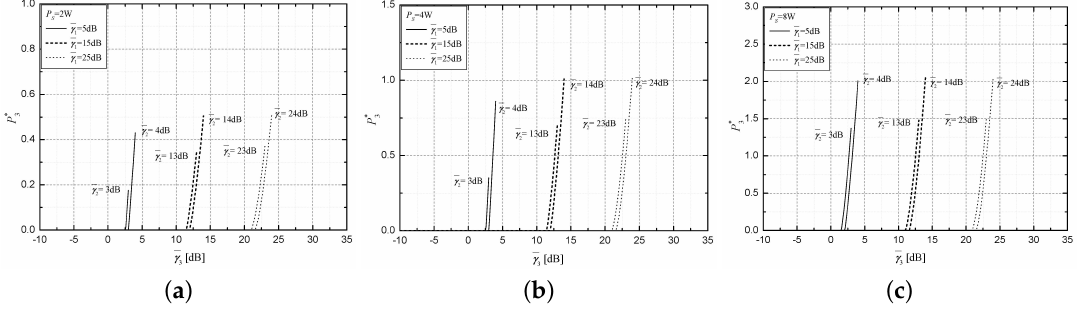
Figure 3. P ∗ versus ¯ γ 3 [dB], with ¯ γ 1 [dB] and ¯ γ 2 [dB] as parameters: ( a ) P S = 2 W, ( b ) P S = 4 W, 3 ( c ) P S = 8